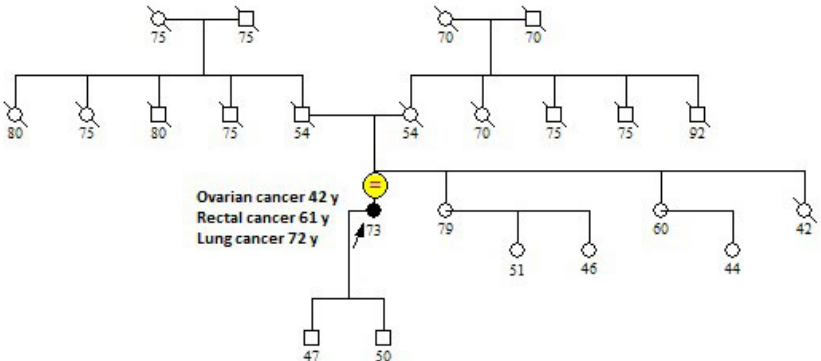
Explor Target Antitumor Ther. 2021;2:240-8 |